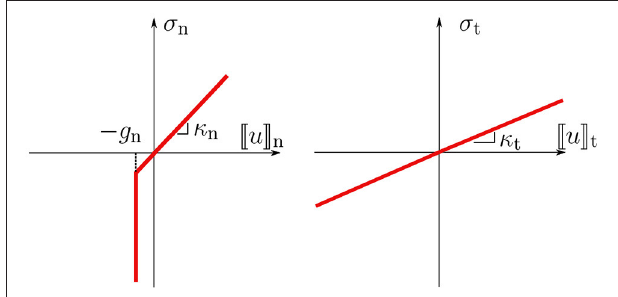
FIGURE 3 | Constitutive relations for the adhesive unilateral contact